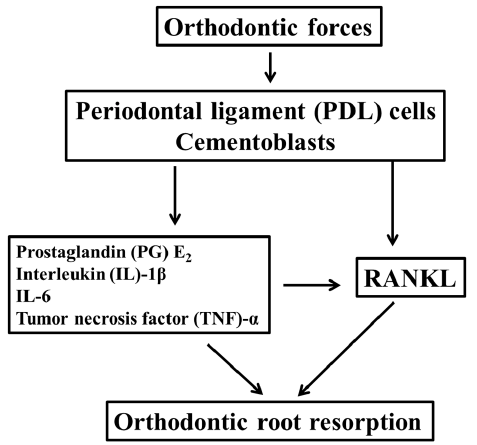
Figure 3. The role of RANKL in